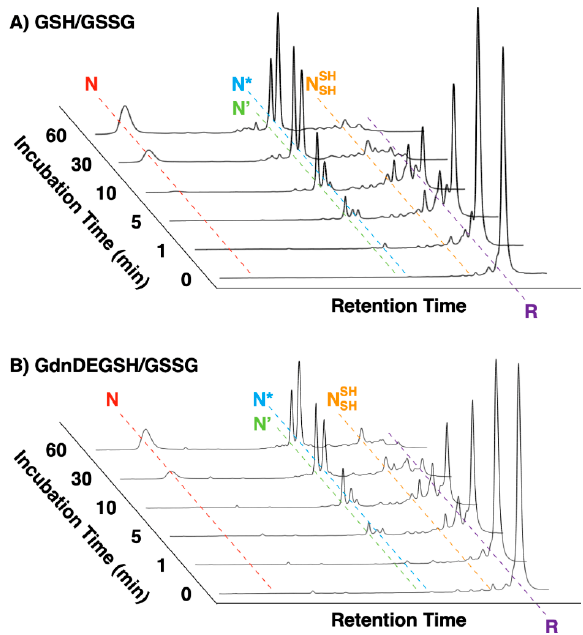
Figure 4. Time course reverse-phase HPLC analyses of oxidative folding of bovine pancreatic trypsin inhibitor (BPTI) (30 μ M) in the presence of ( A ) GdnDEG-SH and GSSG and ( B ) GSH and GSSG (thiol compounds: 1.0 mM; GSSG: 0.20 mM). N and R represent native and reduced forms of BPTI, respectively. N’, N*, and N SH SH represent folding intermediates of BPTI. Column: Tosoh Bioscience TSKgel Protein C4-300 ( ϕ 4.6 × 150 mm); eluent buffers: water (containing 0.05% trifluoroacetic acid (TFA)) and CH 3 CN (containing 0.05% TFA) with a linear gradient; flow rate: 1.0 mL min − 1 ; detection wavelength: 229 nm; temperature: 25 ◦